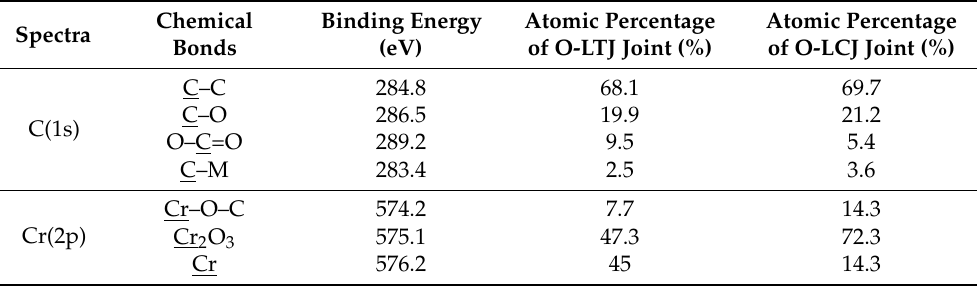
Table 3. Percentage of atoms with different chemical bonds after split-peak fitting of C(1s) spectra and Cr(2p)